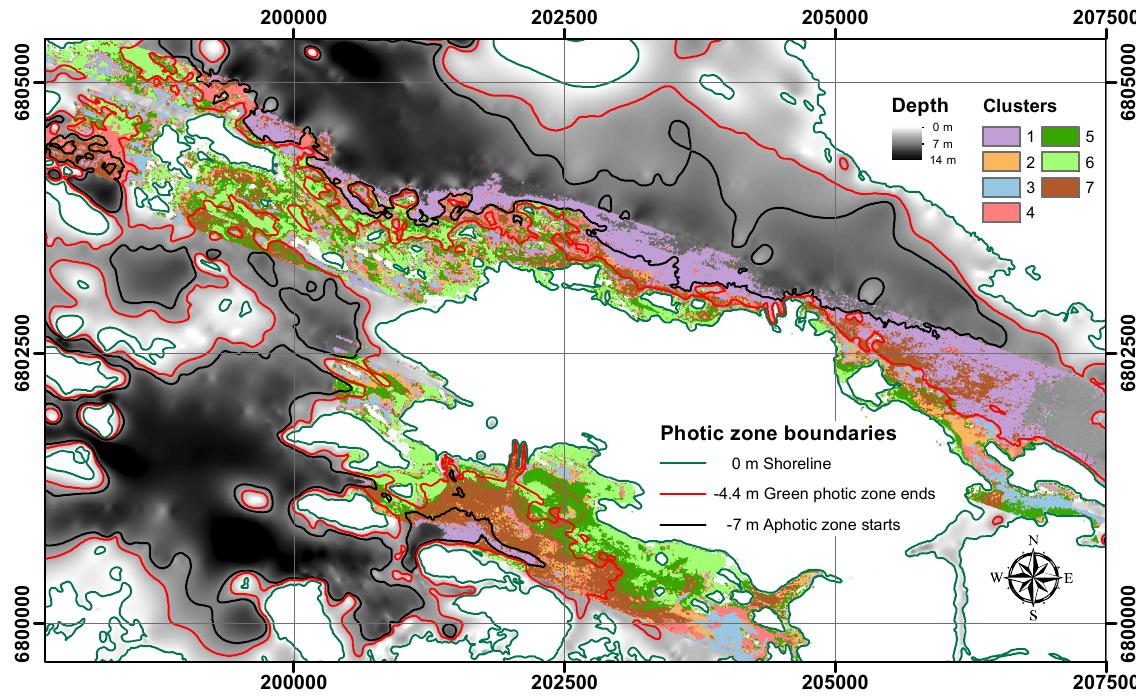
Figure 9. Cluster map of the study area with seven clusters. The photic zones are also indicated on the map.